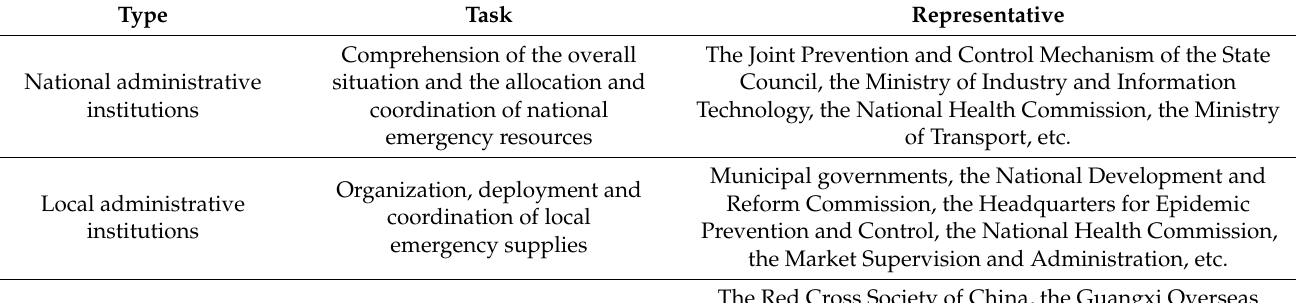
Table 1. Organizational system of supply support in public health